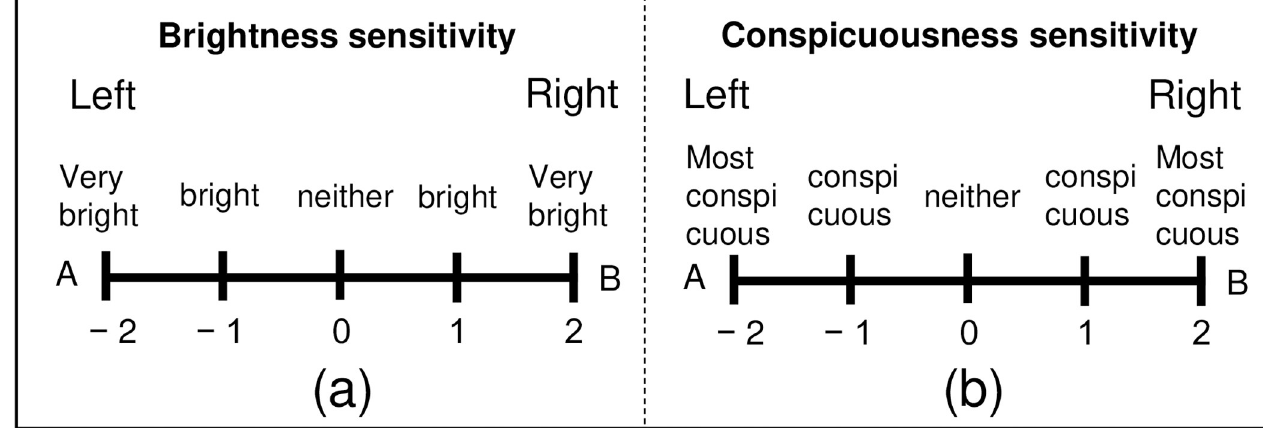
Fig 5. Evaluation items (English version). (a) Brightness sensitivity evaluation sheet. (b) Conspicuousness sensitivity evaluation sheet. The two samples were compared, with the item circled having the highest brightness and conspicuity.